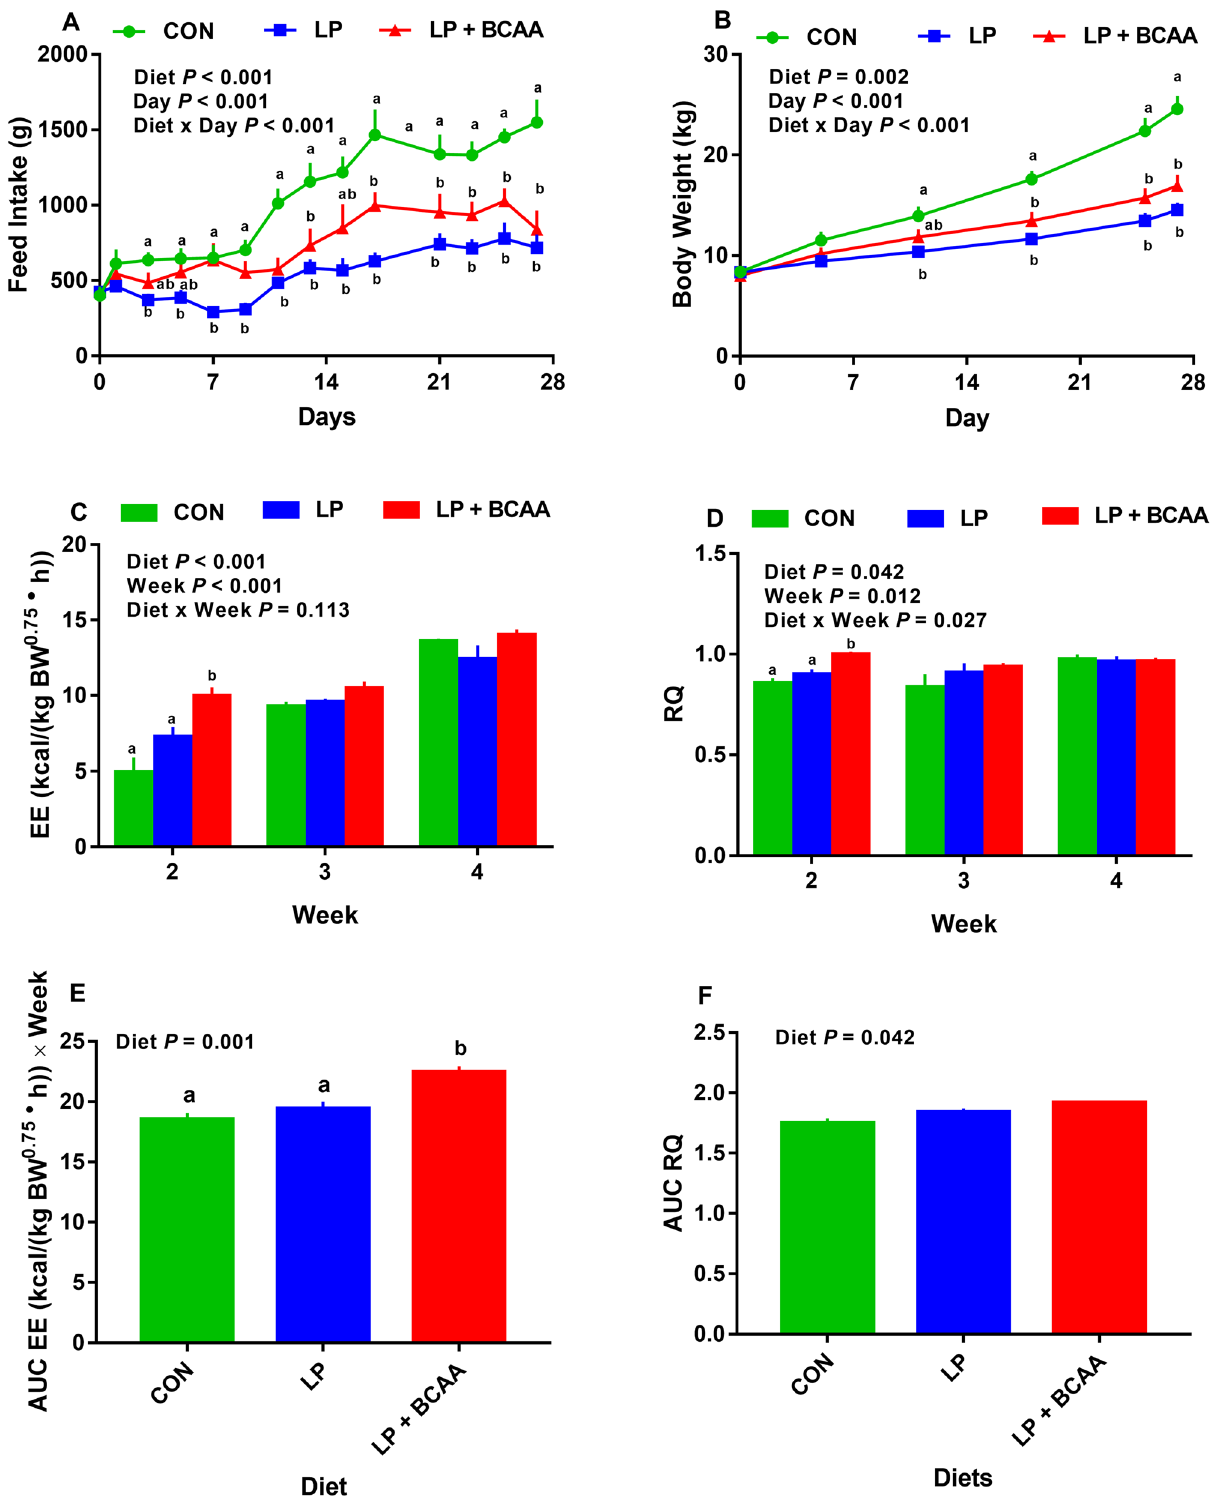
Figure 1. Effect of very low protein diets supplemented with branched-chain amino acids on energy balance. ( A ) feed intake, ( B ) body weight, ( C ) mean energy expenditure (EE), ( D ) mean respiratory quotient (RQ), ( E ) area under curve (AUC) for EE, and ( F ) AUC for RQ. CON, control diet; LP, low protein diet; LP + BCAA, low protein diet supplemented with branched-chain amino acids. Among groups, values with different superscripts are different ( P ≤ 0.05). The values are means ± standard errors of means, n =